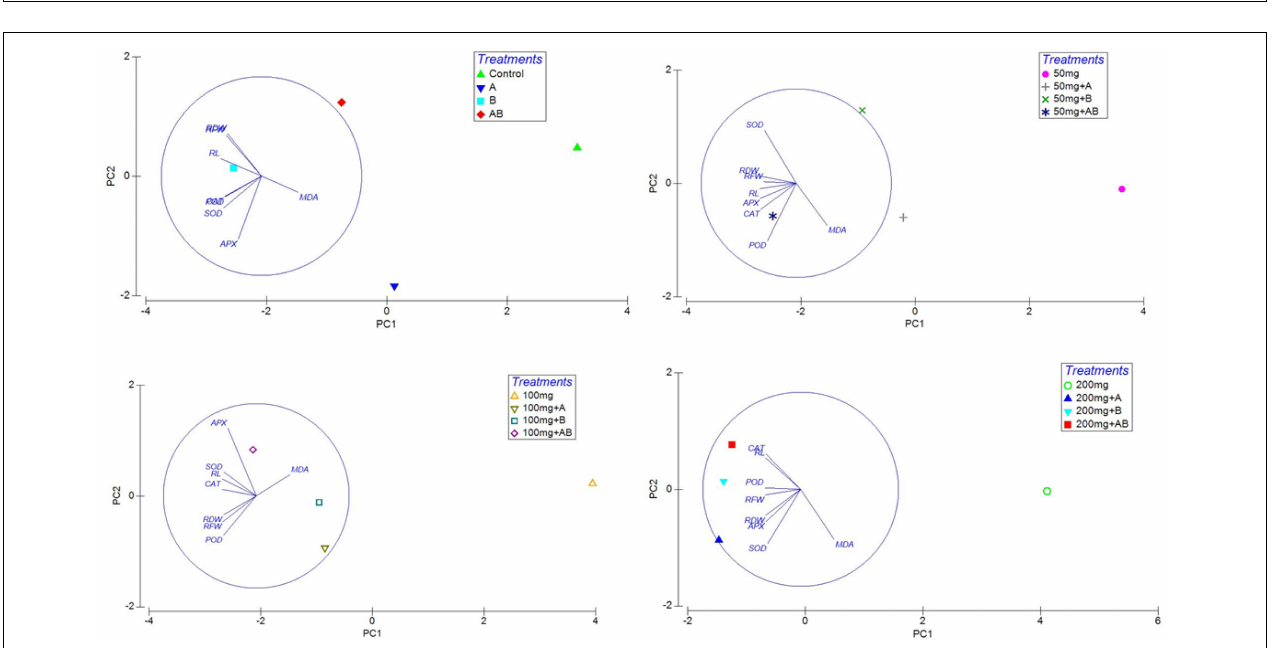
FIGURE 10 | Principal coordinate analysis (PCA) of the effect of bacterial inoculation on RL, root length; RFW, root fresh weight; and RDW, root dry weight and antioxidants in wheat roots. Details of treatments are the same as those in Figure 1 .